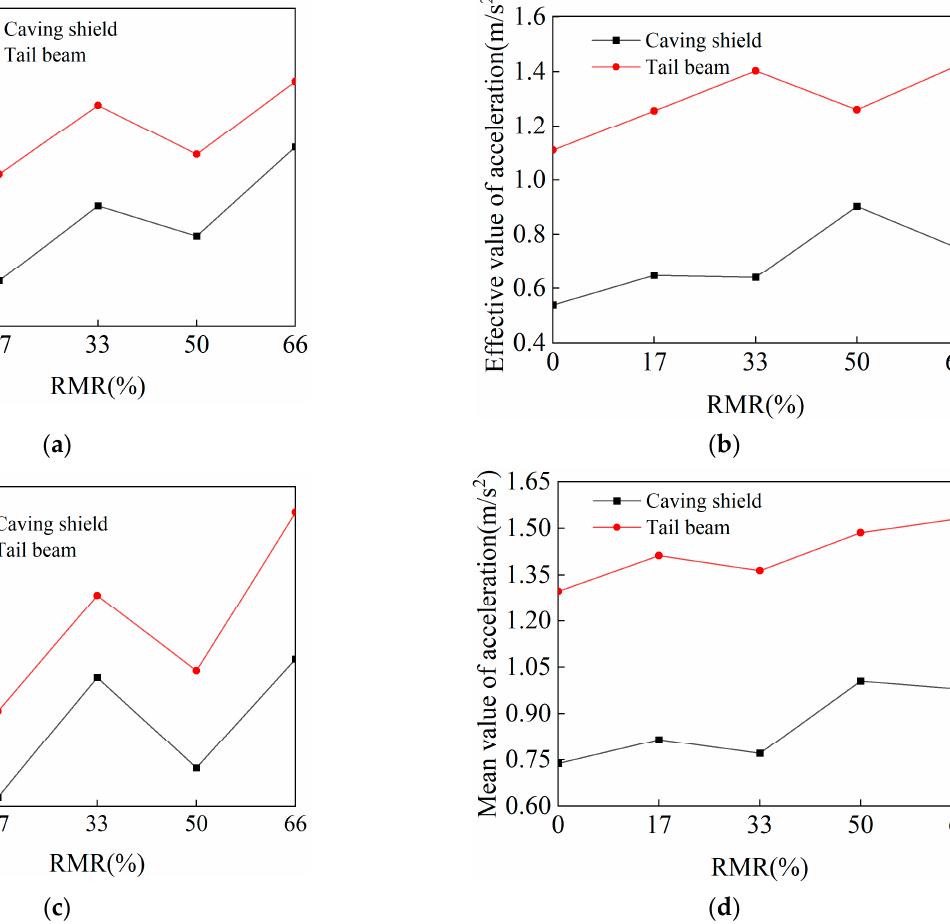
Figure 15. Vibration response of caving shield and tail beam under the impact and slip. ( a ) RMR versus effective value of velocity. ( b ) RMR versus effective value of acceleration. ( c ) RMR versus mean value of velocity ( d ) RMR versus mean value of acceleration.